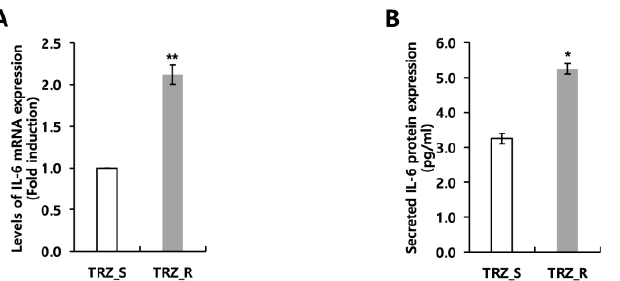
Figure 2. IL-6 expression is upregulated in TRZ_R cells compared to the TRZ_S cells. The levels of IL-6 mRNA and protein expression were analyzed by quantitative real-time PCR (qPCR) ( A ) and enzyme-linked immunosorbent assay (ELISA) ( B ), respectively. Each experiment was carried out three independent times. Data are presented as the mean ± SEM (* p < 0.05, ** p < 0.01).